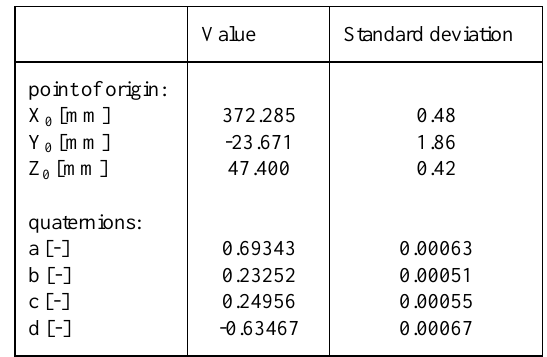
Figure 2. Calibration environment The results of such a calibration are shown in Table 1.